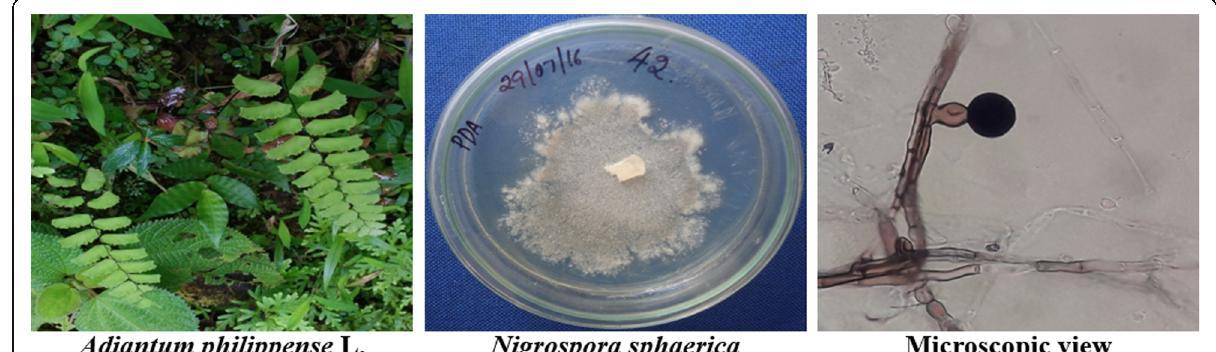
Fig. 1 Plant specimen, morphology, and microscopy of Nigrospora